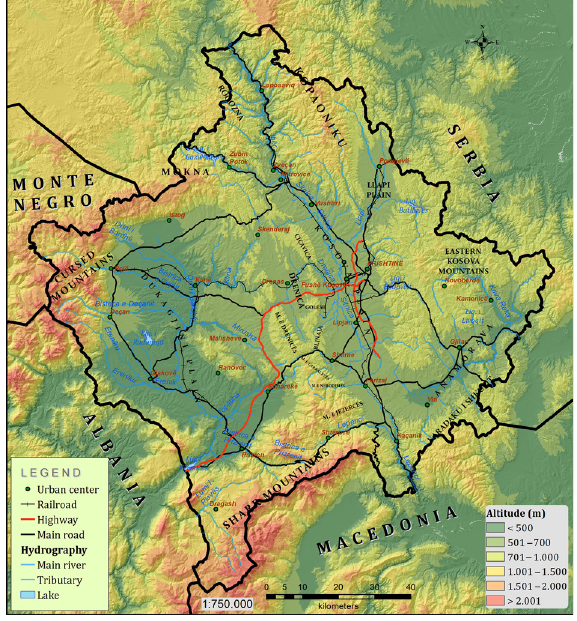
Fig. 2. Physical map of Kosovo. Source: V.